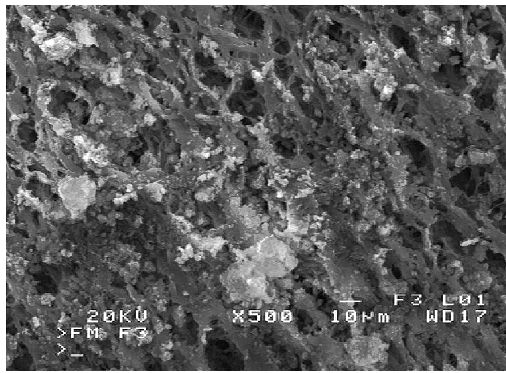
Figure 8. SEM image of salt deposits on the membrane surface. Module MD1.